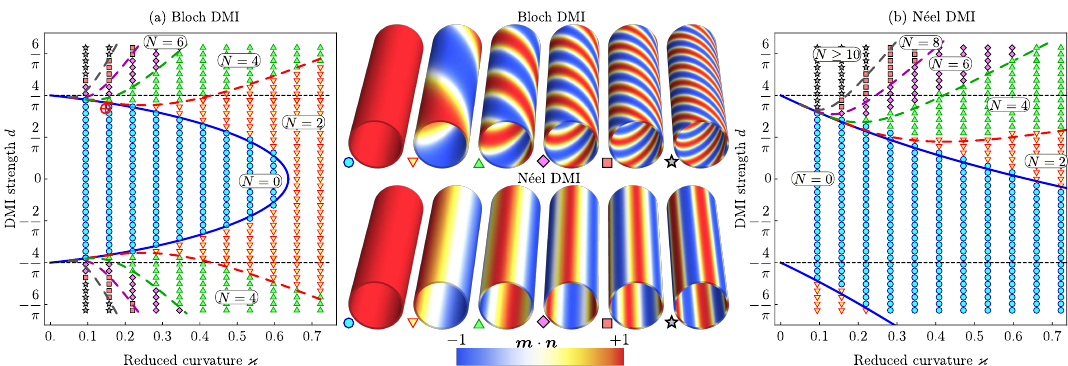
Figure 3: Equilibrium states in tubular shells: (a) and (b) show phase diagrams of equilibrium states in tubular shell with Bloch and Néel type of intrinsic DMI, re- spectively. Symbols display the results from numerical simulations: circles – nor- mal (hedgehog) magnetization distribution ( m = ± n ); other symbols – periodic states (gray stars correspond to states with q ≥ 5). Blue solid lines in (a) and (b) are analytical critical lines determined by Eqs. (8) and (12), respectively; dashed lines in (a) and (b) mark transitions, where the periodic equilibrium states change their number of DWs, as determined by numerical solution of energies equality ( q ) = (cid:69) per ( q + 1 ) and (cid:69) per ( q ) = (cid:69) per ( q + 1 ) : q = 1 corresponds to red dashed (cid:69) per B B N N line, q = 2 – green, q = 3 – purple, q = 4 – gray. Dashed black horizontal lines = ± 4 /π . Symbol ⊕ in (a) correspond to critical DMI parameter in a flat systems d 0 corresponds to the boundary between the hedgehog and periodic states obtained by means of micromagnetic simulations in Ref. [ 32 ]